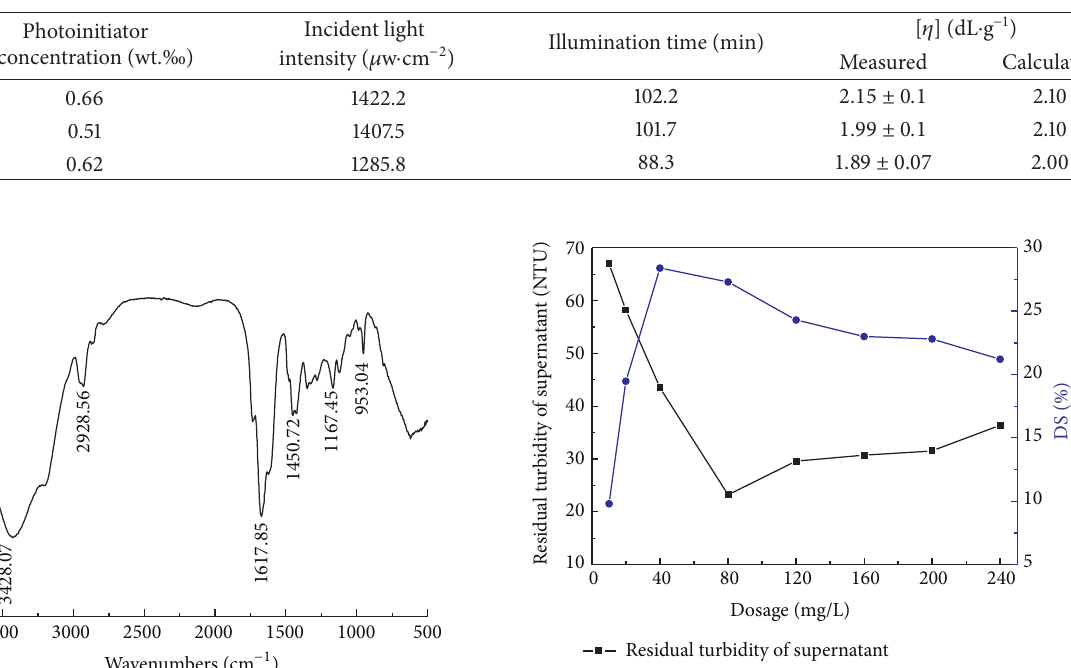
Table 4: Measured and calculated values for confirmation experiments.